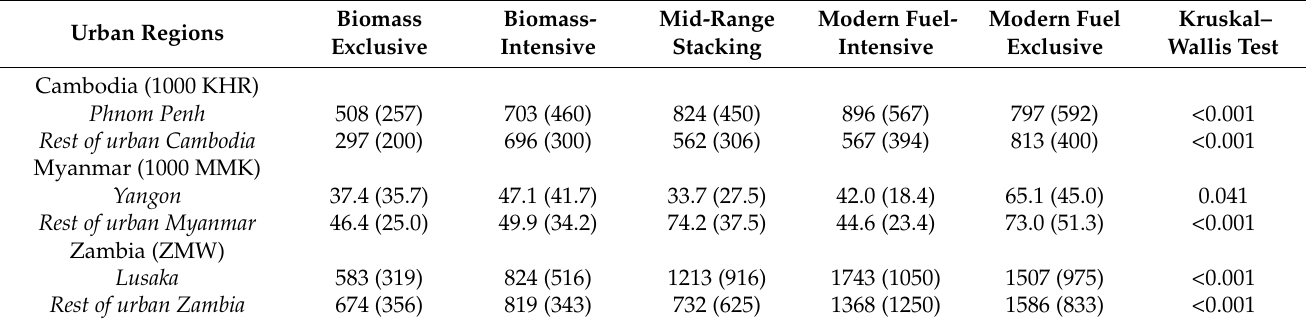
Table 6. Average monthly household incomes per capita in local currency (mean (median)).